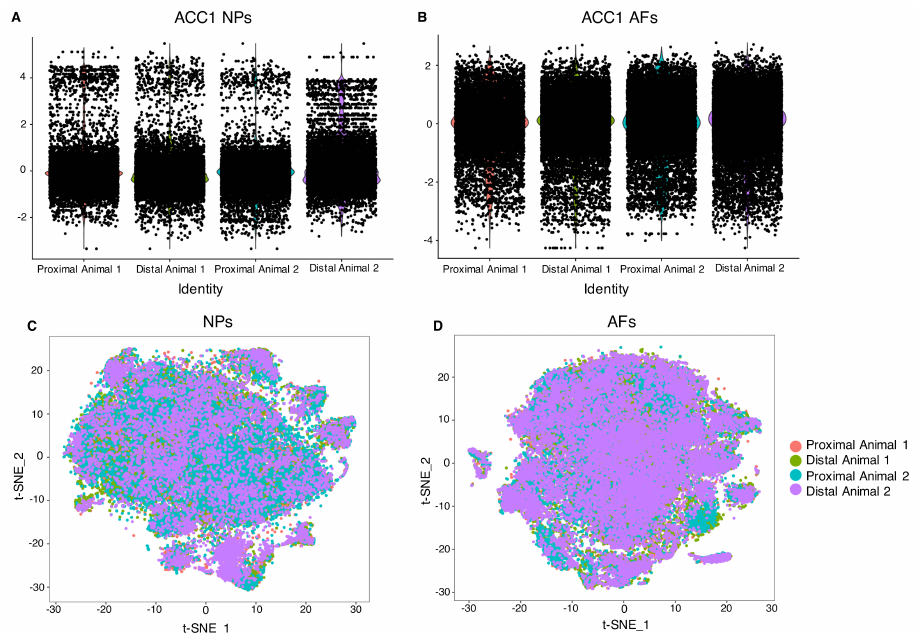
Figure 1. Canonical correlation analysis (CCA). CCA identifies common sources of variation between the datasets for NPs ( A ) and AFs ( B ). The CCA aligned subspaces ACC1 and ACC2 for each condition are plotted as violin plots with the points reflecting the data distribution. The plots reveal high correlation between proximal and distal NPs and AFs within and between animals. t-SNE plot of four CCA corrected NPs samples ( C ) and four CCA corrected AFs samples ( D ). Each dot represents a cell and the different colors are assigned to different samples. The location of a cell is determined by its gene expression profiles, therefore cells that localized in close proximity exhibit a high correlation in their gene expression pattern. In both graphs, the four samples contribute in a comparable way in populating each region of the graph, showing a good overlap among all the NPs ( A ) and among all the AFs ( B